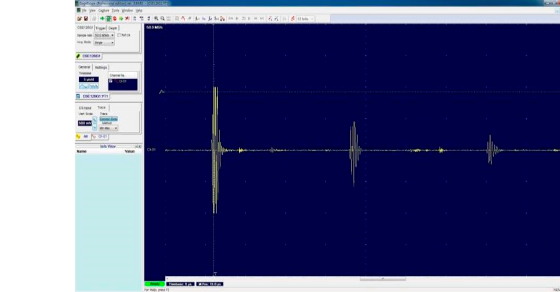
Figure 7. Acoustic signal image obtained using the constructed key element